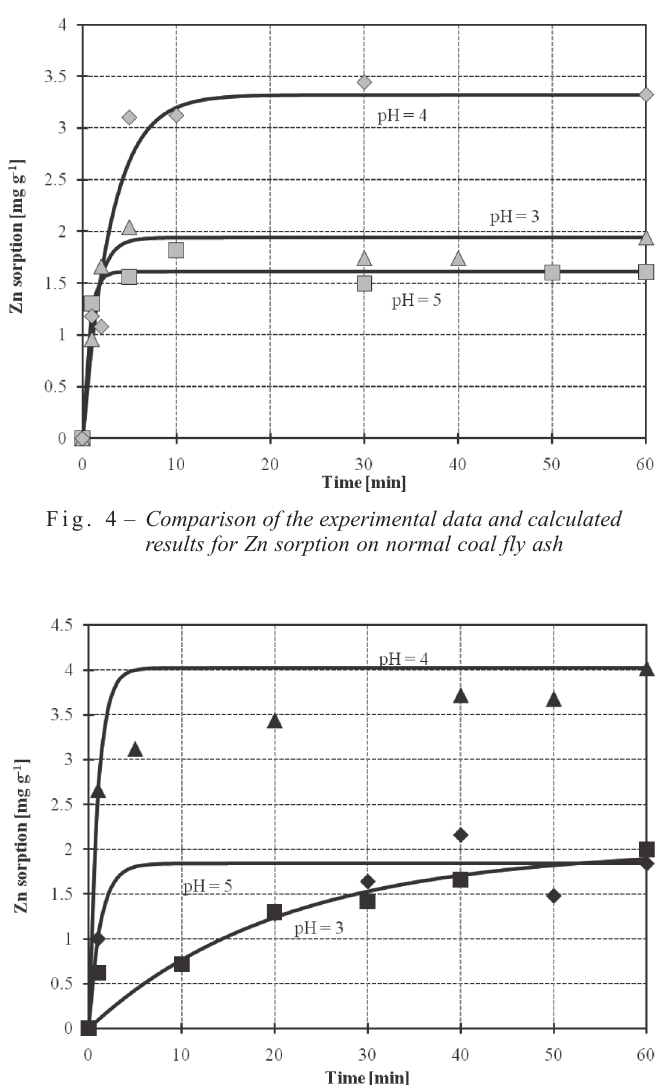
Fig. 5 – Comparison of the experimental data and calculated results for Zn sorption on ultrasonic-activated coal fly